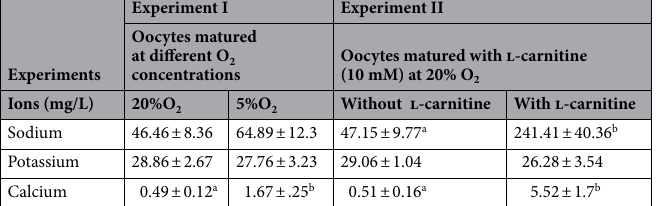
Table 2. Intracellular ions (Na + , K + and Ca 2+ ) concentration of matured oocytes at different level of oxidative status. *Different superscripts in the same row differ significantly at P <